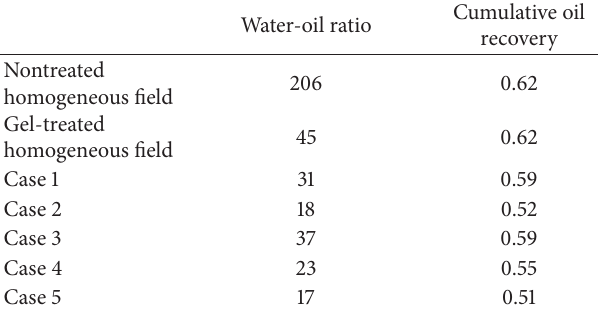
Table 7: Arithmetic means of water-oil ratio and cumulative oil recovery after gel treatment at the 1,000